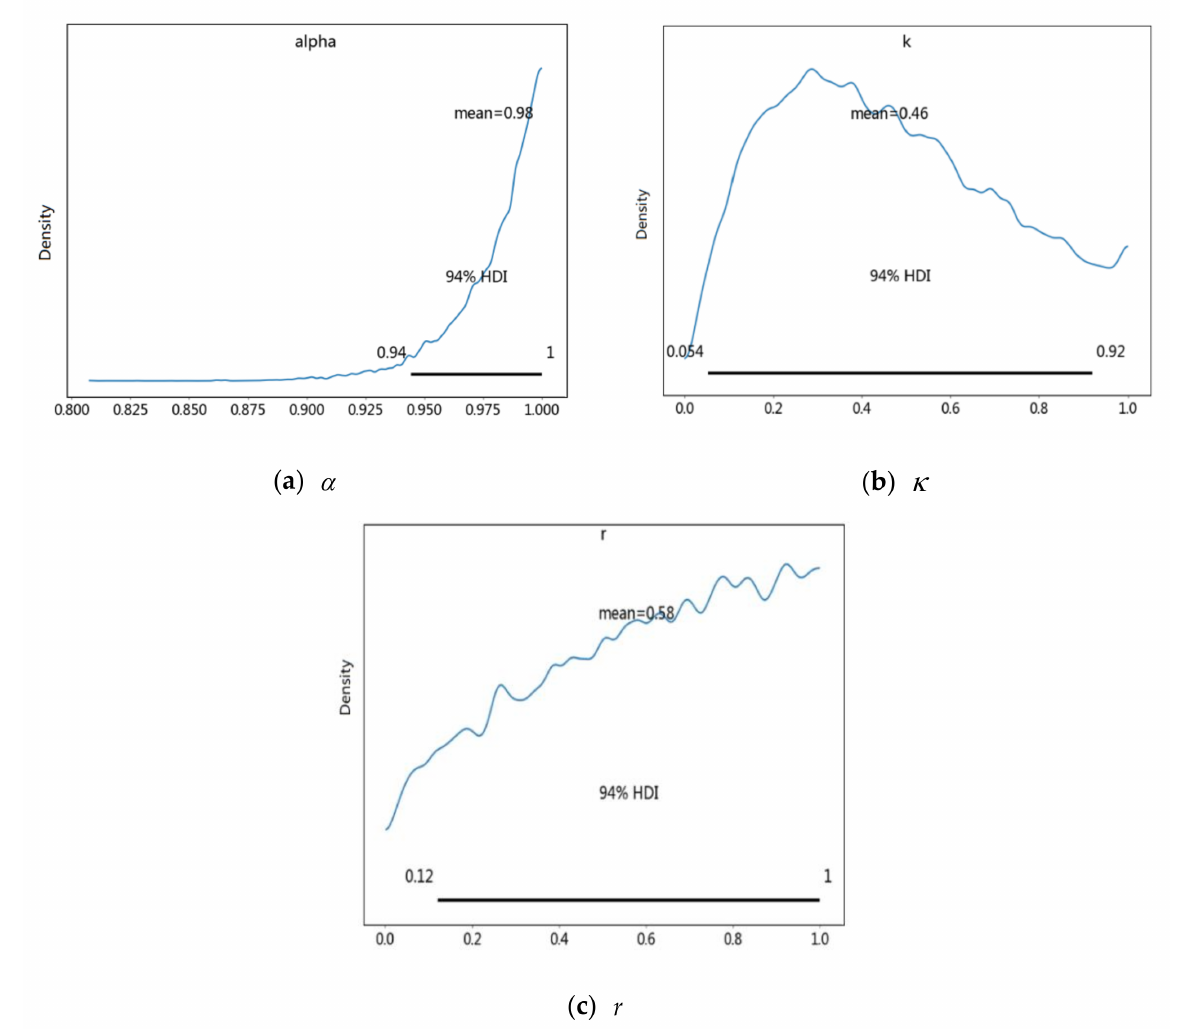
Figure 5. The parameter posterior distribution of anode voltage ( a ) α , ( b ) κ , ( c ) r .